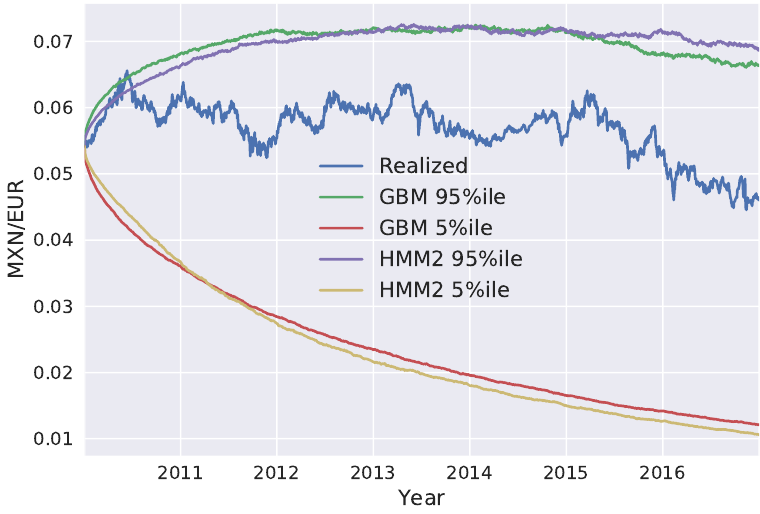
Figure 10. Percentiles of long-term distribution cones for MXN/EUR under GBM and HMM with two